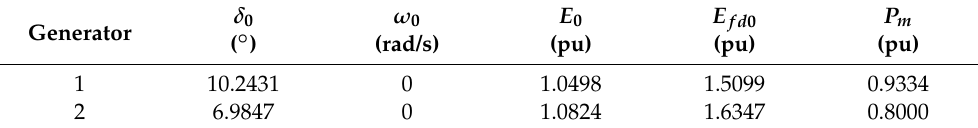
Table 8. Initial conditions for the third case